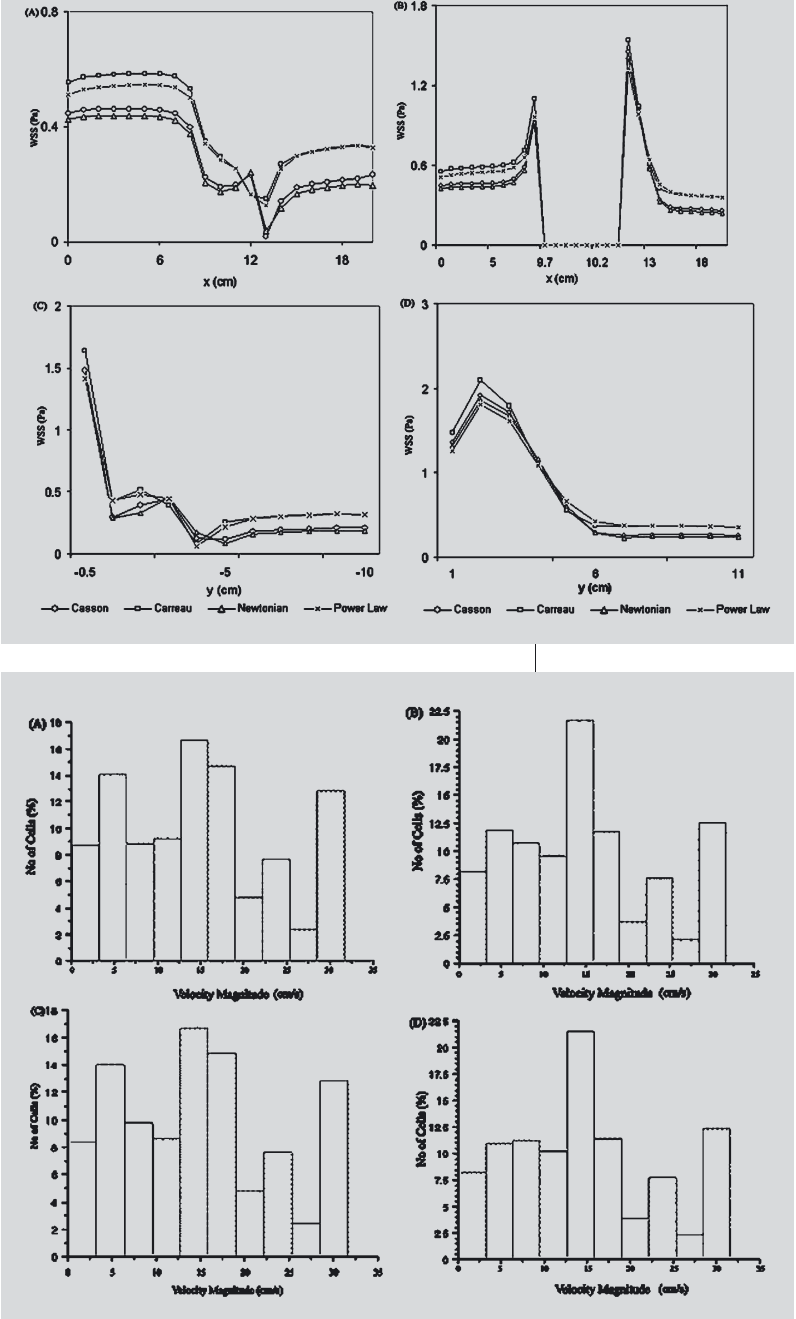
Figure 8: Wall shear stress (WSS): (A) the main tube upper wall, (B) at the main tube lower wall, (C) at the daughter tube left side wall, and (D) at the daughter tube right side wall. Figure 9: Histogram of the velocity magnitude distribution across the flow domain as predicted by rheological models: (A) Casson, (B) Carreau, (C) Newtonian, and (D) power